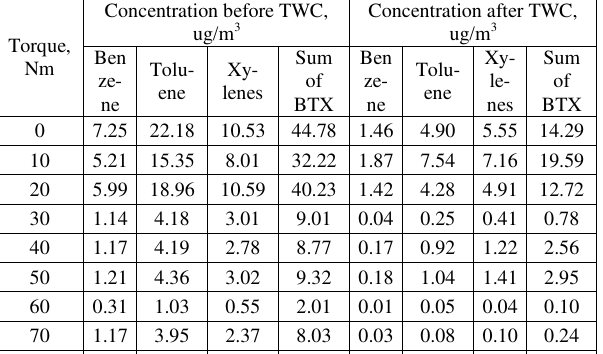
Figure 7 the efficiency of the sum of BTX is shown.